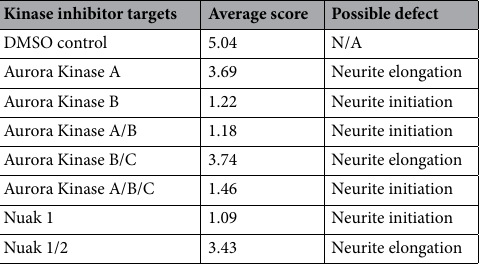
Table 2. Kinase inhibitors that were determined to be negative regulators of neurite formation at 10 µM and regulators of neurite initiation or elongation at all doses (0.1, 1, 10 µM).